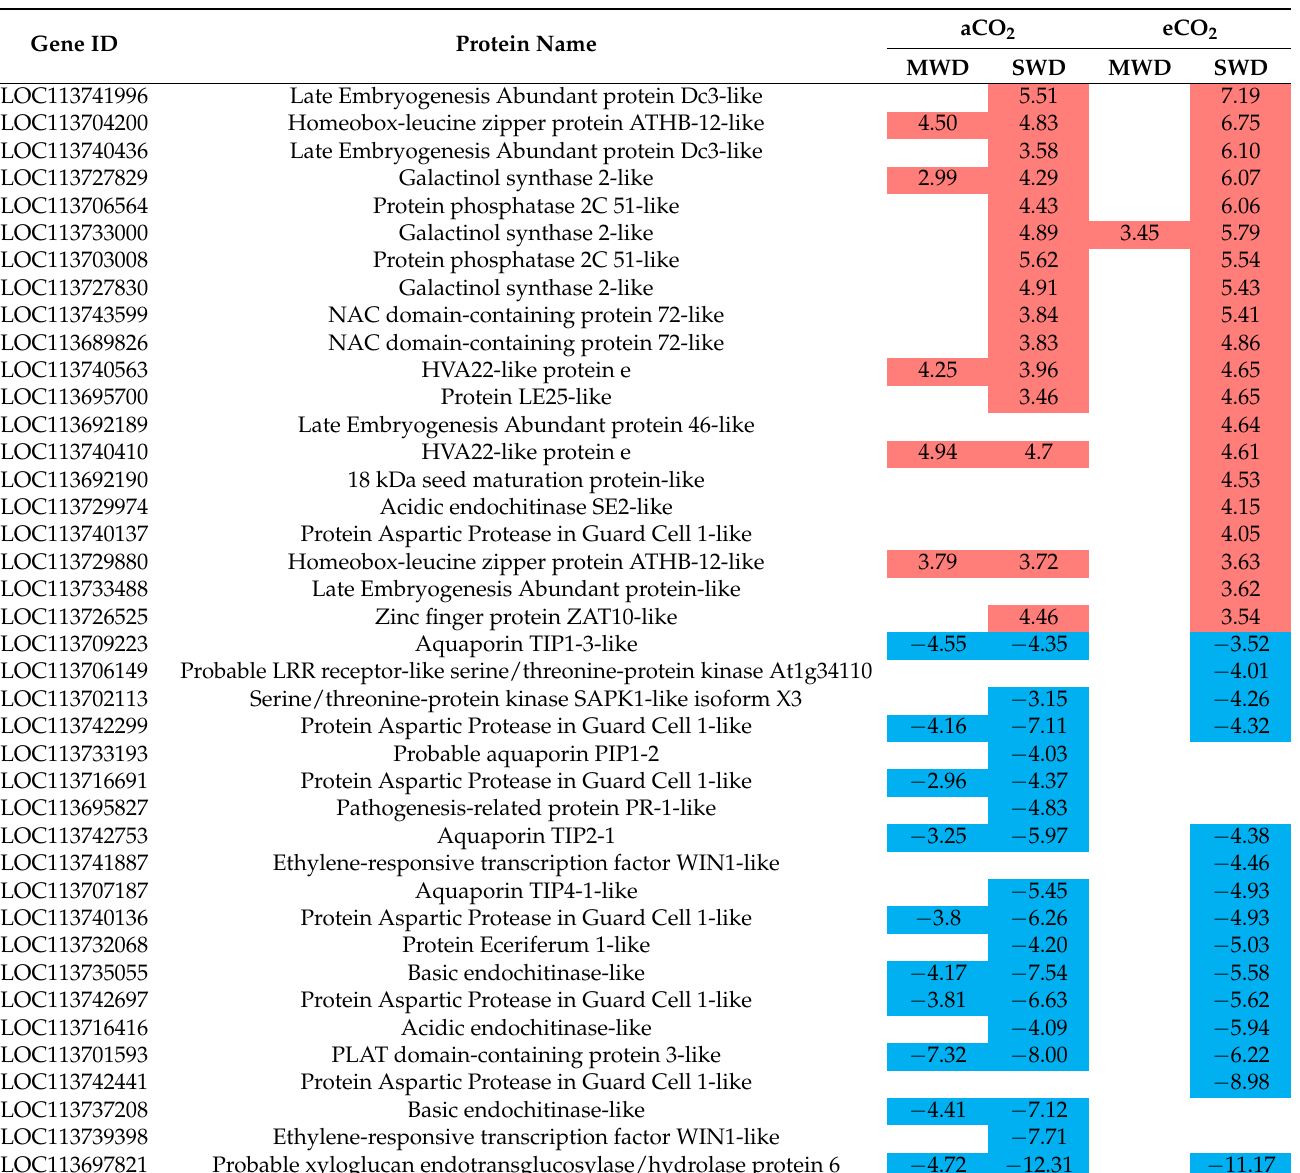
Table 1. Regulation patterns of the top 20 up- and down-differentially expressed genes (DEGs) related to drought responses in Coffea arabica cv. Icatu (Icatu) plants grown under MWD or SWD in comparison with WW plants grown under aCO 2 or eCO 2 , at 25/20 ◦ C (day/night). Blue: down- regulated DEGs; red: up-regulated